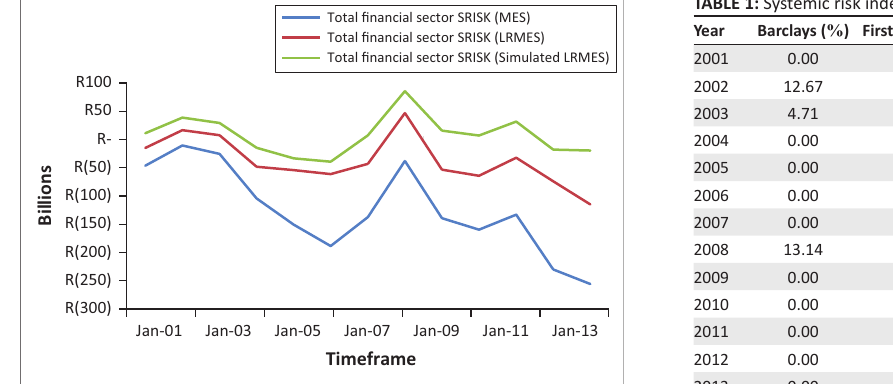
FIGURE 1: Systemic risk index of the South African financial sector.